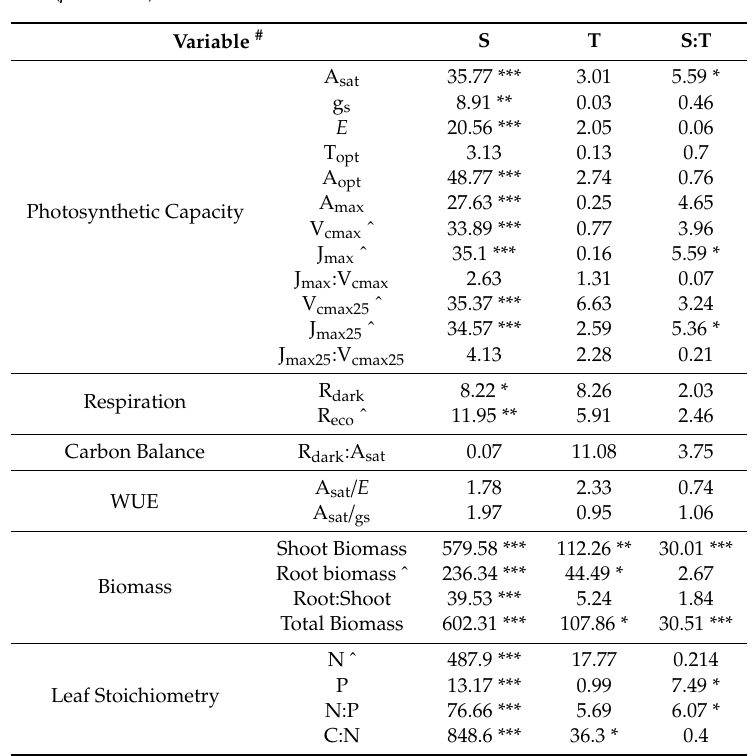
Table 1. F values of linear mixed e ff ects models and their interactions on parameters for lucerne ( Medicago sativa ) and tall fescue ( Festuca arundinacea ), with Species (S) and growth temperature (T) as fixed e ff ects and growth chamber as the random e ff ect. Statistical significance denoted by * ( p < 0.05), ** ( p < 0.01) & *** ( p <